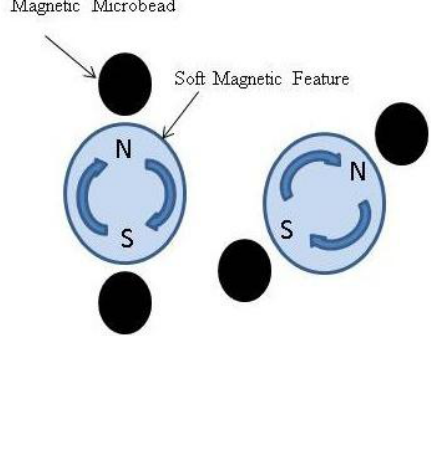
Figure 1. Magnetic attraction between paramagnetic beads and induced magnetic poles. As the external permanent magnet rotates, the induced poles within the soft magnetic features also rotate, pulling the magnetic